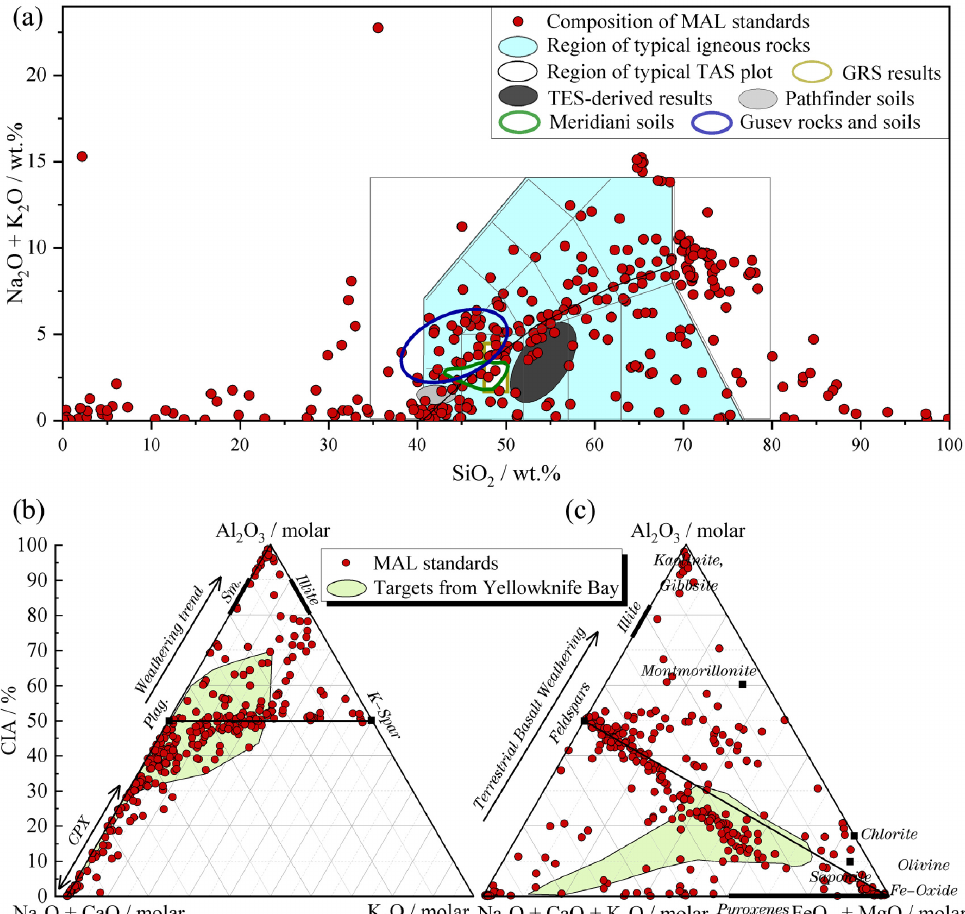
Figure 5. Geochemical characteristics of MAL standards: ( a ) Total alkali-silica plot of all 316 MAL standards, with the TES-derived data and GRS results, as well as compositions of rocks and soils at the Pathfinder landing site, Gusev crater, and Meridiani Planum from McSween et al. (2009) [29]. The polyline in the region of typical igneous rocks (cyan) is the alkaline–subalkaline boundary from Irvine et al. (1971) and Sautter et al. (2015) [27,28]; ( b ) ternary diagram of Al 2 O 3 -(CaO + Na 2 O)-K 2 O with CIA values on the vertical axis; ( c ) ternary diagram of Al 2 O 3 -(CaO + Na 2 O + K 2 O)-(FeO T + MgO). ChemCam results from Yellowknife Bay in the Gale crater (green polygon) are from McLennan et al. (2014) [30].